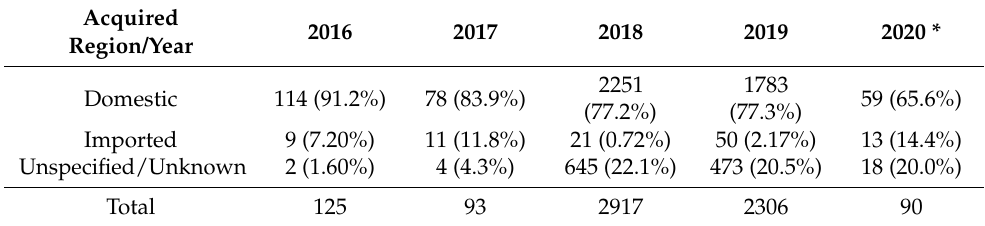
Table 4. Reported rubella cases, aggregated by acquired region